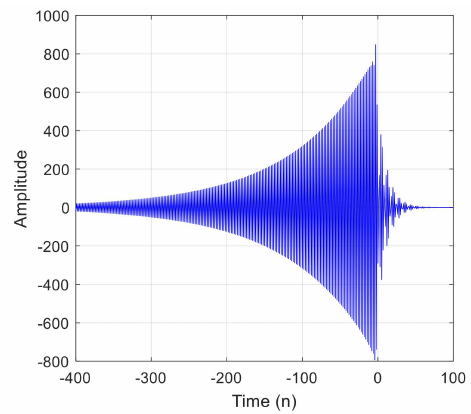
Figure 4. The impulse response of the noncausal inversion for the secondary